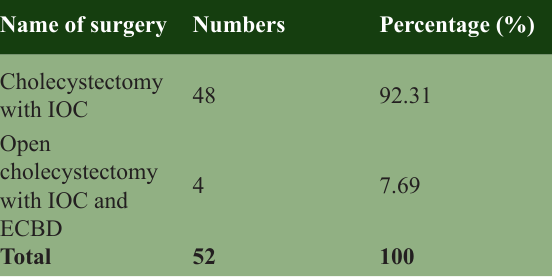
Table 1: Surgical management of patients with resolving mild acute biliary pancreatitis (n=52) Name of